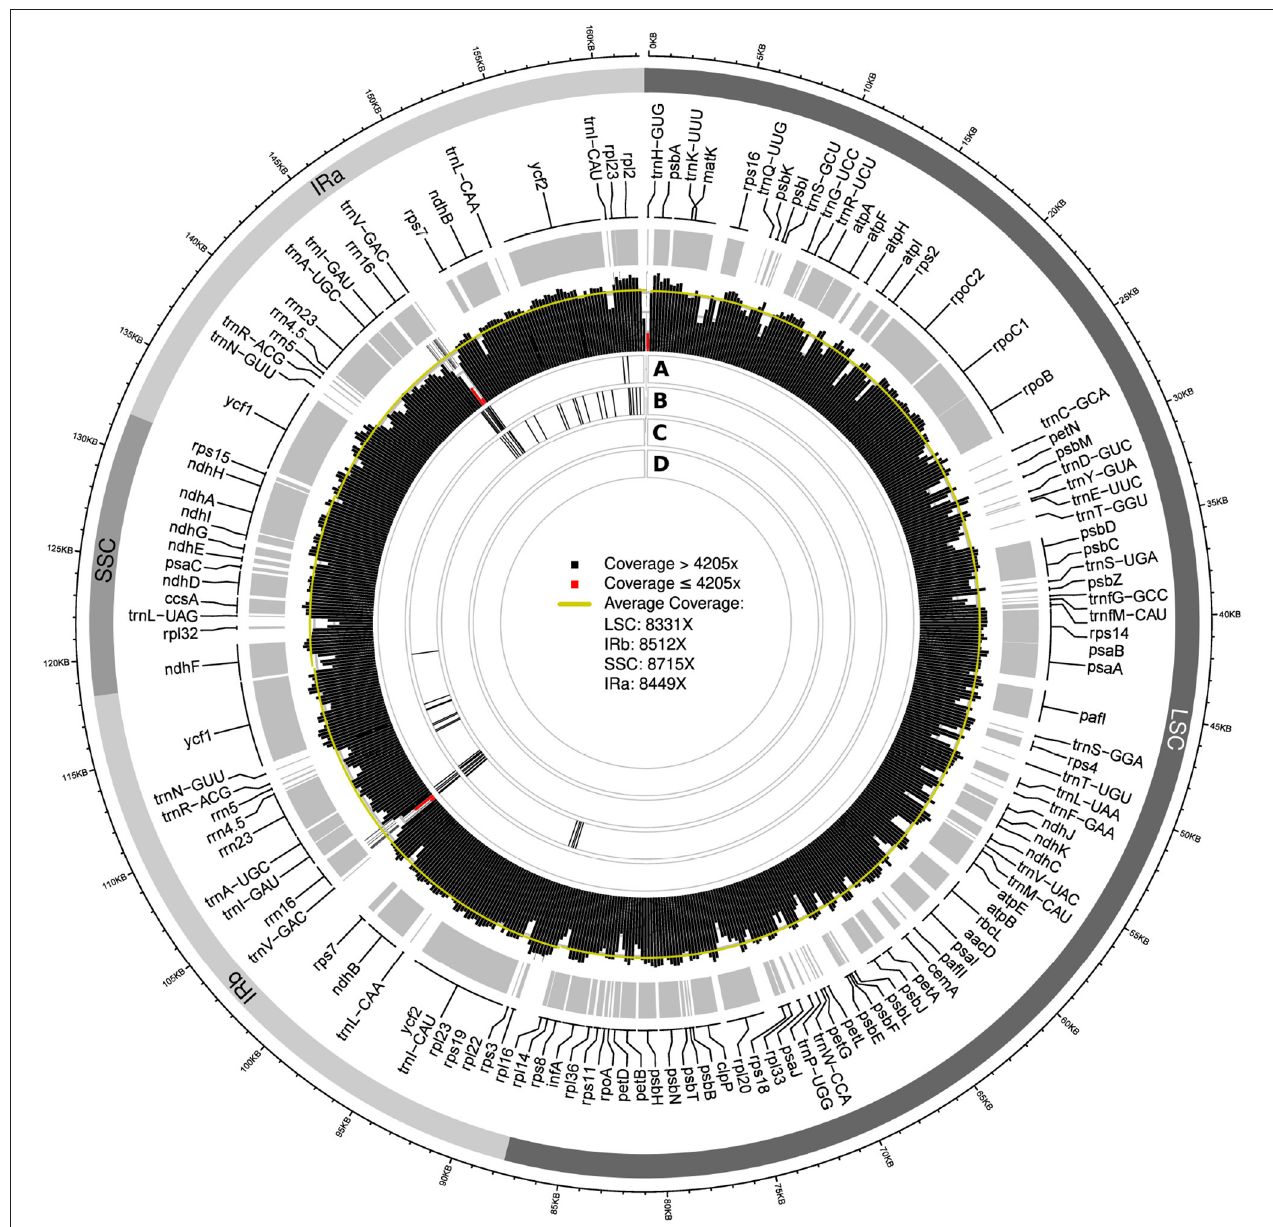
FIGURE 5 | Visualization of the sequencing coverage across the plastid genome of individual Cb01A as generated with FastPlast and the location of SNPs of assemblies generated under different levels of sequencing coverage. Red bars in the visualization of sequencing coverage indicate calculation windows with a depth equal to, or less than, 50% of genome-wide sequencing depth. The four rings beneath the coverage visualization indicate the location of SNPs relative to the final genome sequence for the following assemblies: replicate run 1 (A) and 2 (B) under the original sequencing depth; a coverage cap of 2,000x (C); a coverage cap of 500x (D). Black bars within each ring represent the occurrence of three SNPs per 100 bp.